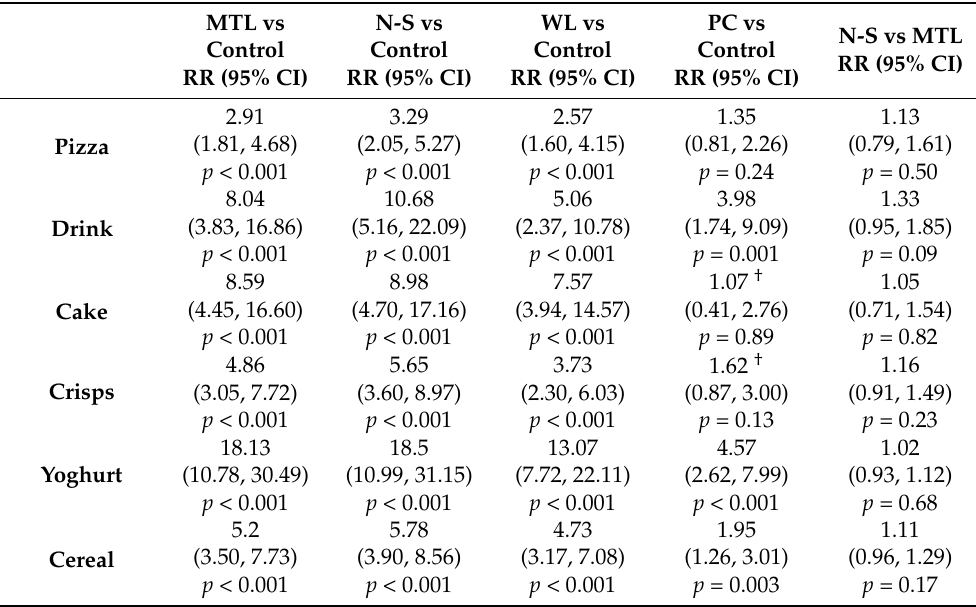
Table 3. Log-binomial regression results—relative risk that ranking of healthiest product improved (follow-up vs baseline) between FOPL group and control (adjusted for design factors and